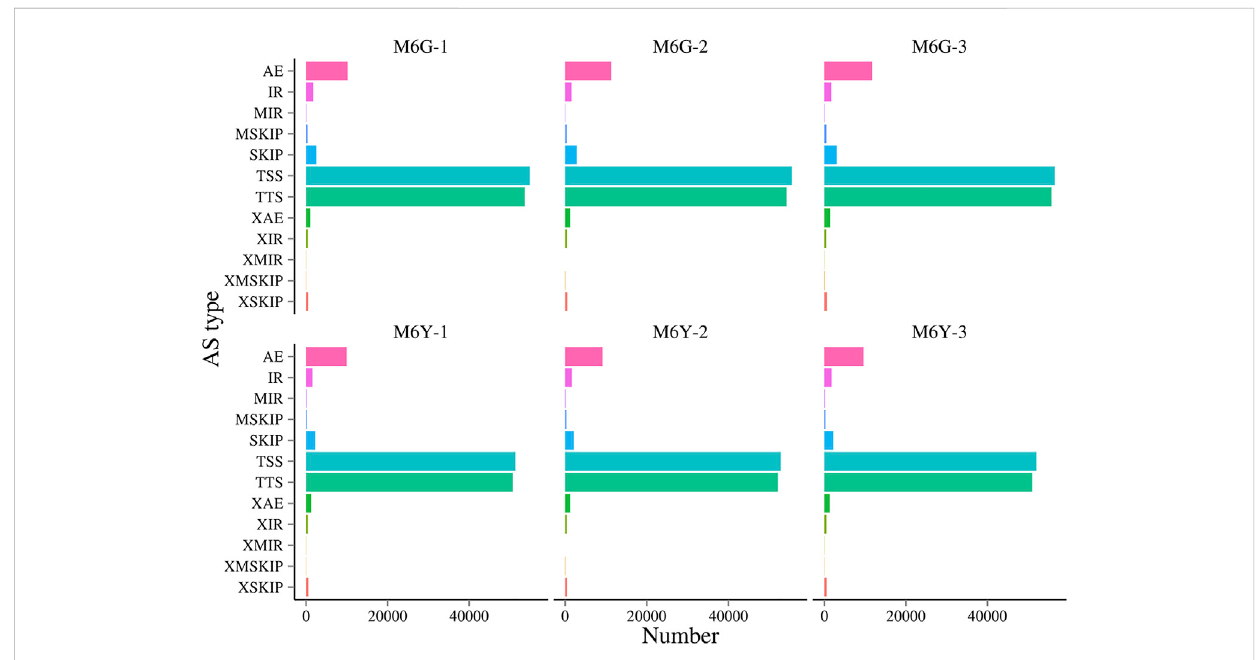
FIGURE 6 Different alternative splicing types in M6Y and M6G